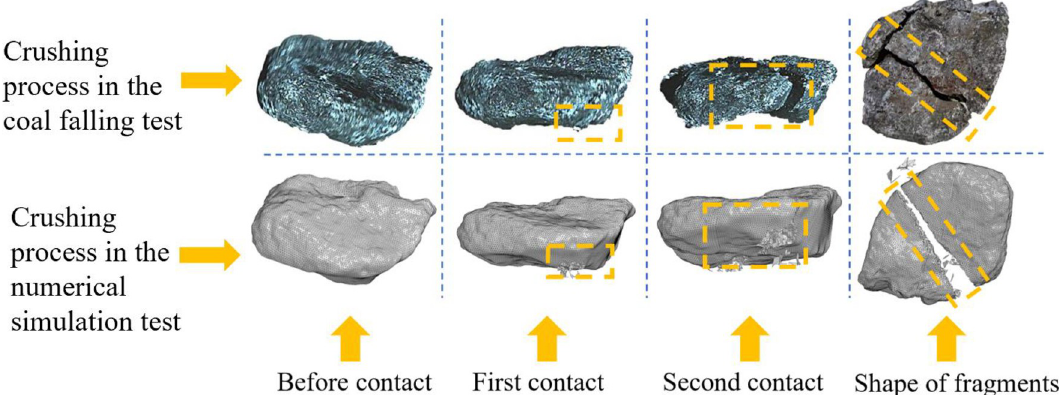
Fig 6. Comparison of the real test and numerical simulation.